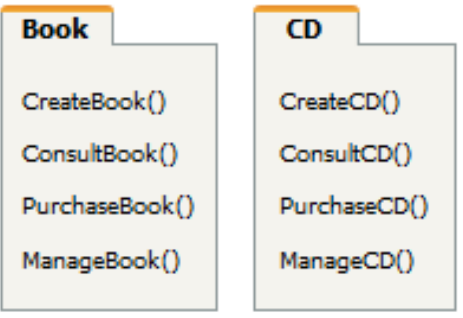
Fig. 6. Conceptual Model of the Online Library study case